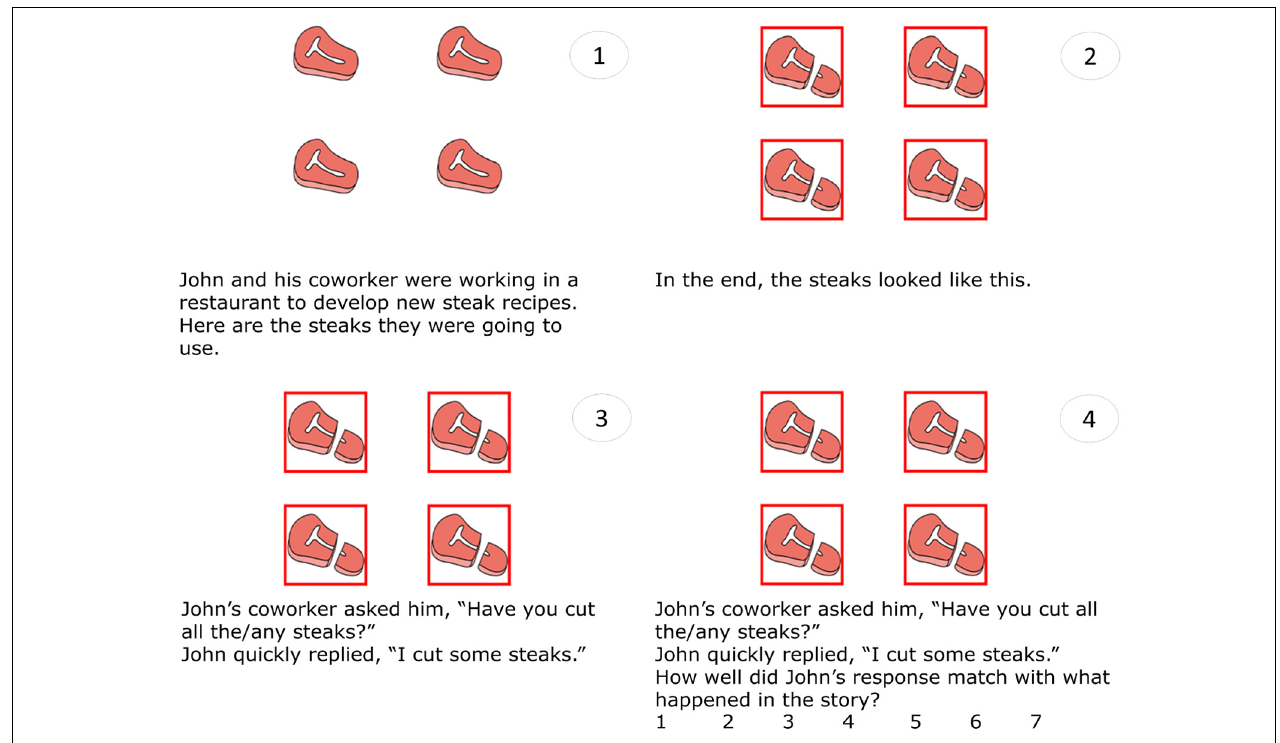
FIGURE 1 | Sample display of a target trial in the main story-sentence matching task. Each trial is depicted on four consecutive slides, numbered 1–4